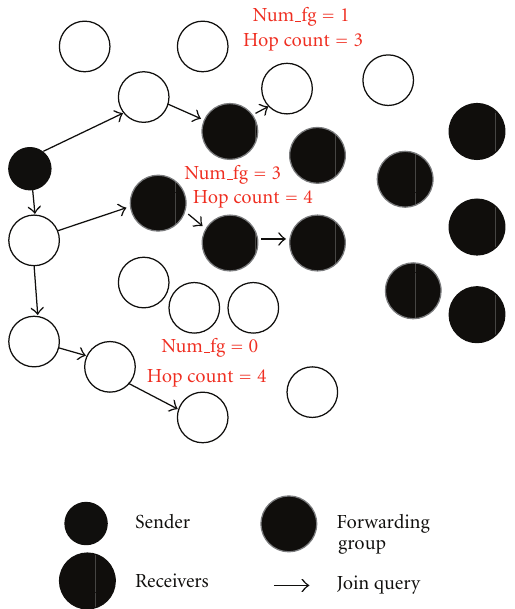
Figure 2: Intersection of new forwarding group with previous forwarding